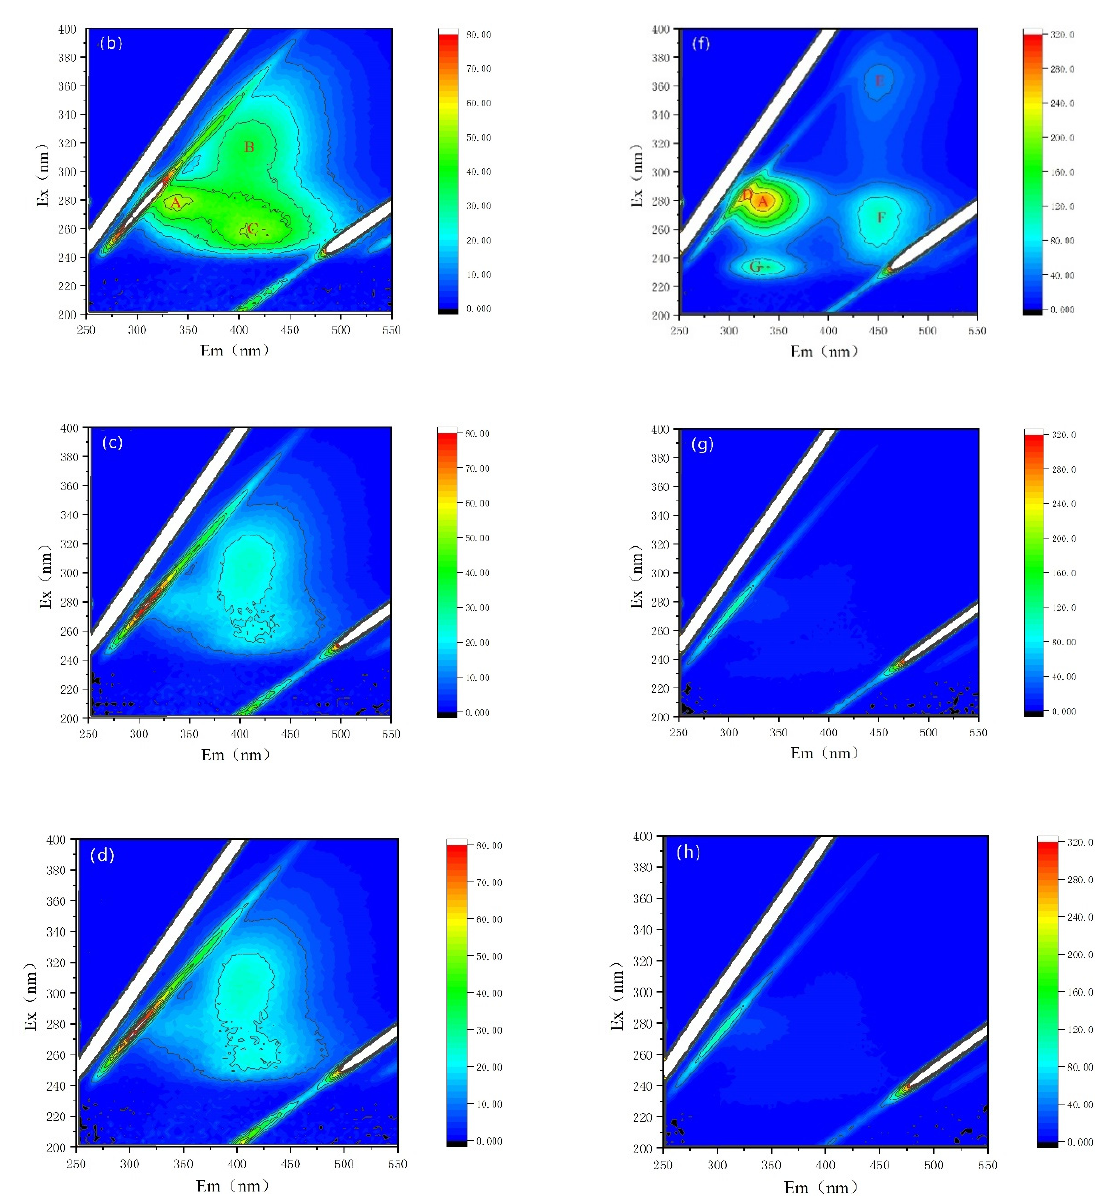
Figure 5. Fluorescence properties of the EOM and IOM fractions: ( a – d ) are the CK, NZVI, H 2 O 2 , and NZVI/H 2 O 2 treatments for the EOM fraction; ( e – h ) are the CK, NZVI, H 2 O 2 , and NZVI/H 2 O 2 treatments for the IOM fraction.